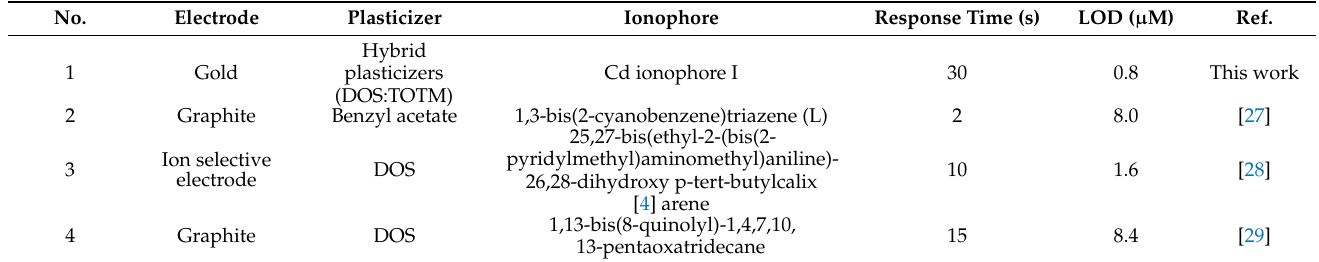
Figure 13. Sensitivity testing of the hybrid plasticizer sensor composed of TBACl at the optimal SE and pH, ( n = 5). The slope of the graph is 0.00875 µ A/ppb. Table 3. Comparison of the detection limits of cadmium(II) at various modified electrodes.